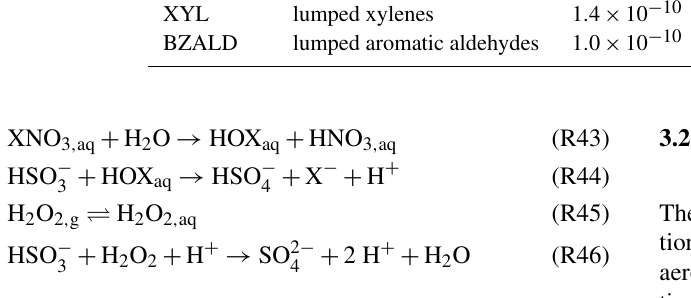
Table 2. Description of the lumped MOZART4 species and the corresponding kinetic reaction rate constants. Species Comment k Comment on k BIGALK alkanes with no. of C ≥ 4 2 . 05 × 10 − 10 same as for butane ALKOH alcohols with no. of C ≥ 3 2 . 7 × 10 − 11 e 525 / T same as for propanol C 2 H 5 CHO aldehydes with no. of C ≥ 3 4 . 9 × 10 − 12 e 405 / T OH; same as for propionaldehyde Cl; same as for propionaldehyde Br; same as for propionaldehyde BIGALD1 unsaturated dialdehyde 1 . 35 × 10 − 10 same as for 2-butenedial XYL lumped xylenes 1 . 4 × 10 − 10 mean value of o -, p - and m -xylene BZALD lumped aromatic